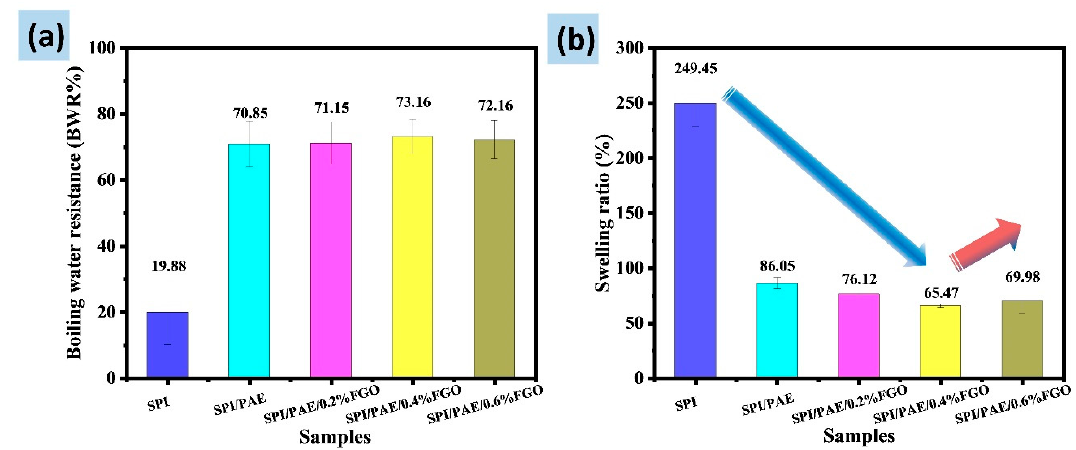
Figure 4. (a) Boiling water resistance and ( b )swelling ratios of different adhesives. Figure 4. ( a ) Boiling water resistance and ( b ) swelling ratios of different